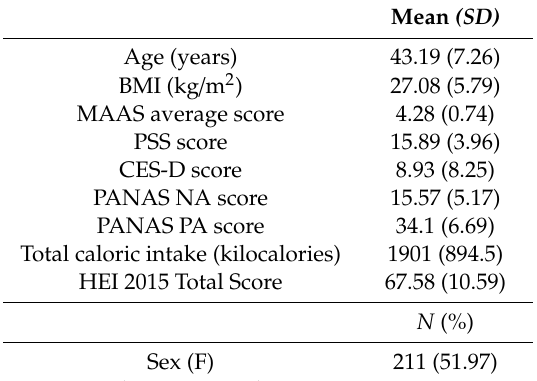
Table 1. Demographic and clinical characteristics of the sample ( N =